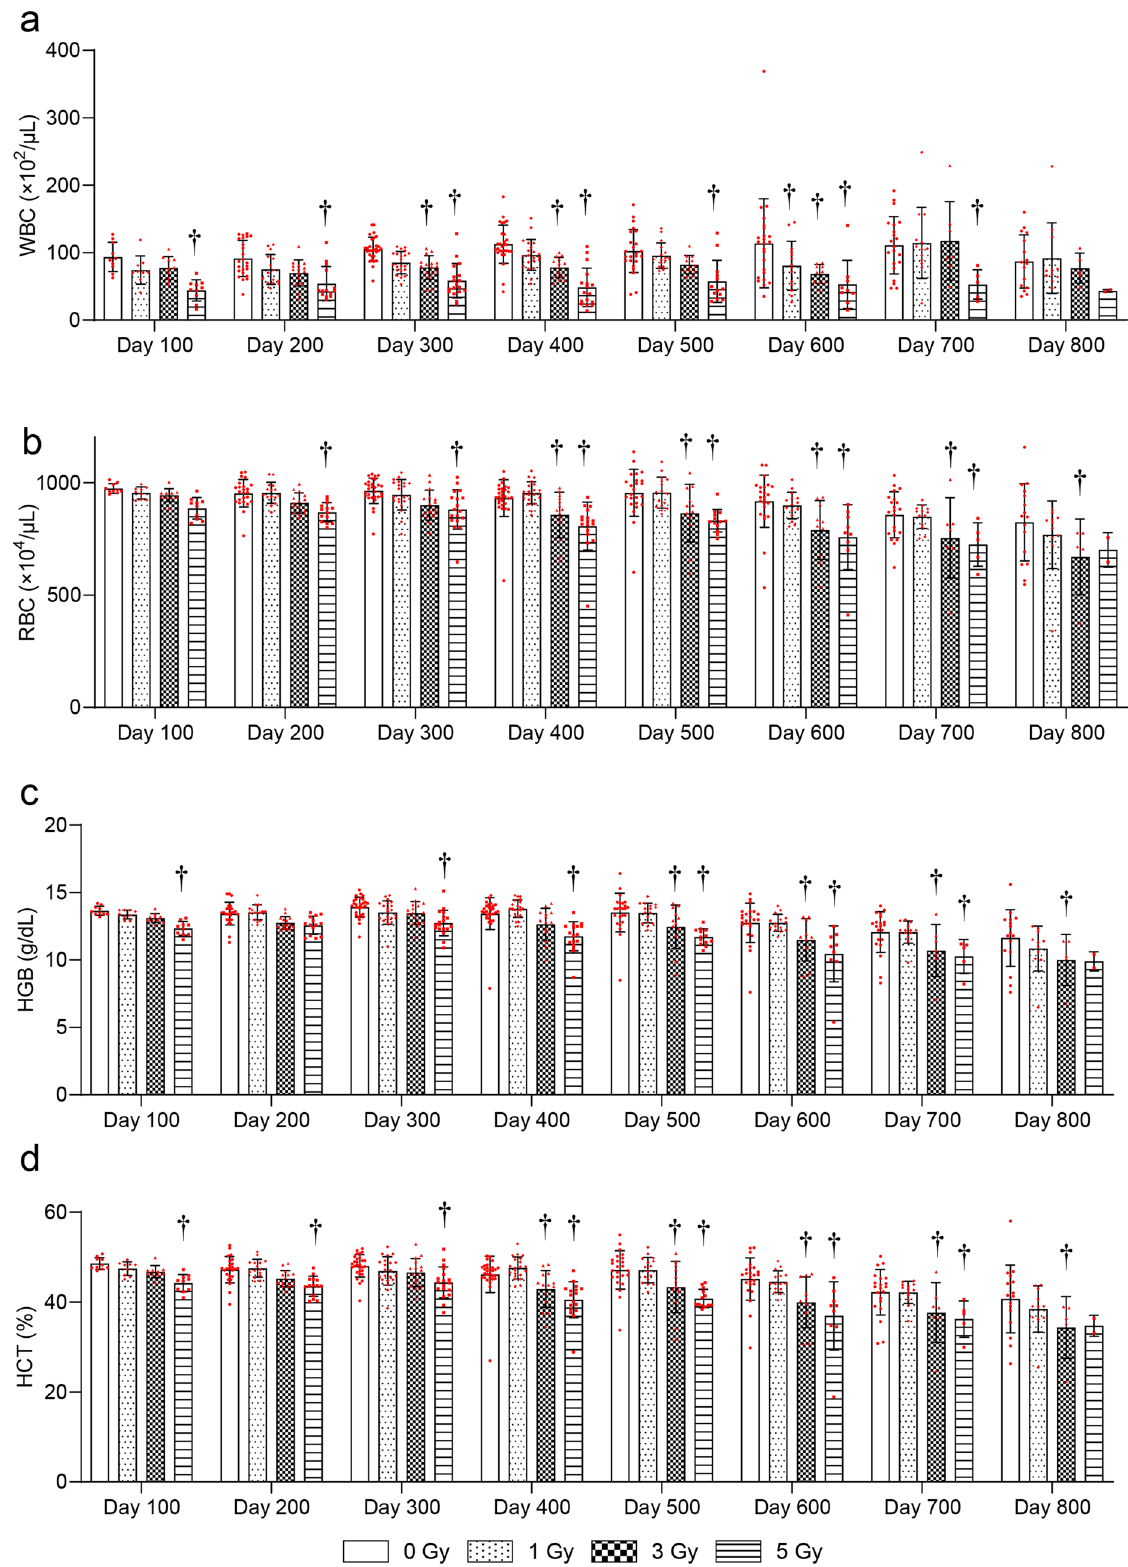
Figure 3. Changes in complete blood counts (CBC) more than 100 days after TBI. Changes in ( a ) white blood cell (WBC) counts, ( b ) red blood cell (RBC) counts, ( c ) hemoglobin (HGB), and ( d ) hematocrit (HCT). Bars indicate the means, error bars indicate the SDs, and red dots indicate individual data points. Two-way ANOVA and the post hoc Dunnett’s test were used to analyze significant differences with the 0-Gy group. † Indicates P <